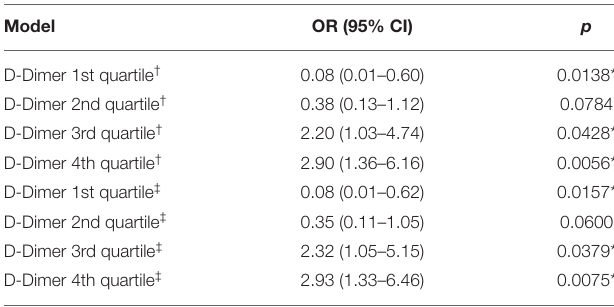
TABLE 5 | Quartiles of post-surgical D-Dimer as predictors of IDDVT after thoracic